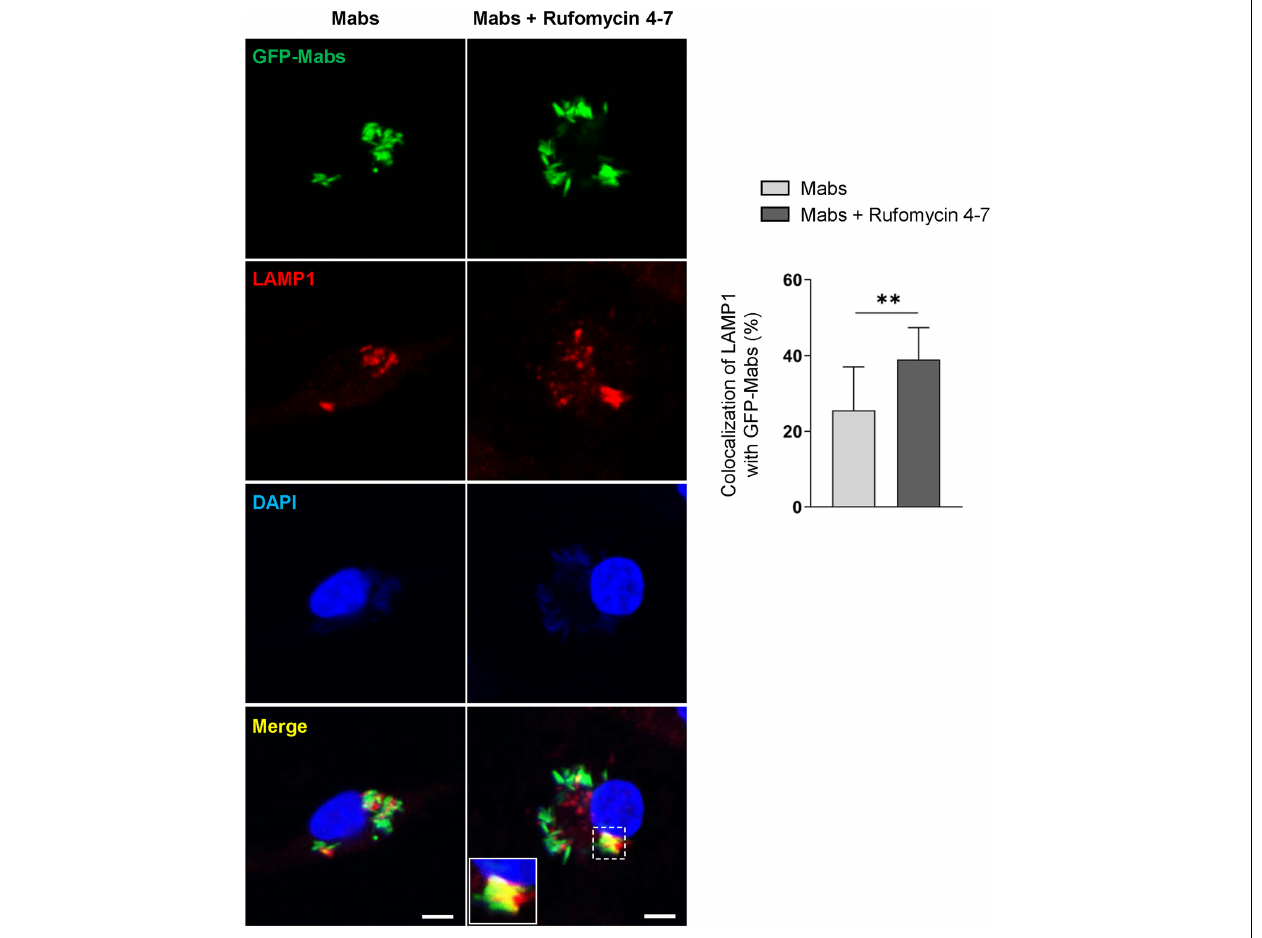
FIGURE 5 | Rufomycin 4–7 increases the colocalization of phagosomes and lysosomes against GFP-Mabs infection. BMDMs were infected with GFP-Mabs (MOI = 3) for 2 h and incubated with Rufomycin 4–7 (10 µ M) for 18 h in the fresh media. Cells were then stained with LAMP1 (red) and DAPI (blue) and subjected to confocal microscopy. Representative confocal images from each group (scale bar: 5 µ m) and the quantitative data of colocalization of LAMP1 and GFP-Mabs were presented ( n = 10 for each group; at least 80 cells per image). ∗∗ p < 0.01. Statistical analysis was determined with unpaired t -test and presented as means ± SD from at least three independent experiments performed in